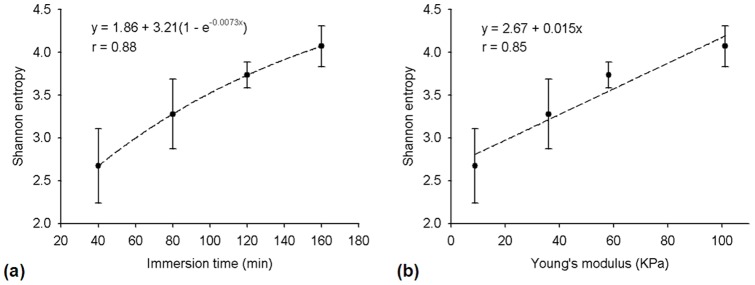
Average entropy as a function of immersion time is shown in (a), and average local entropy as a function of Young's modulus is shown in (b).